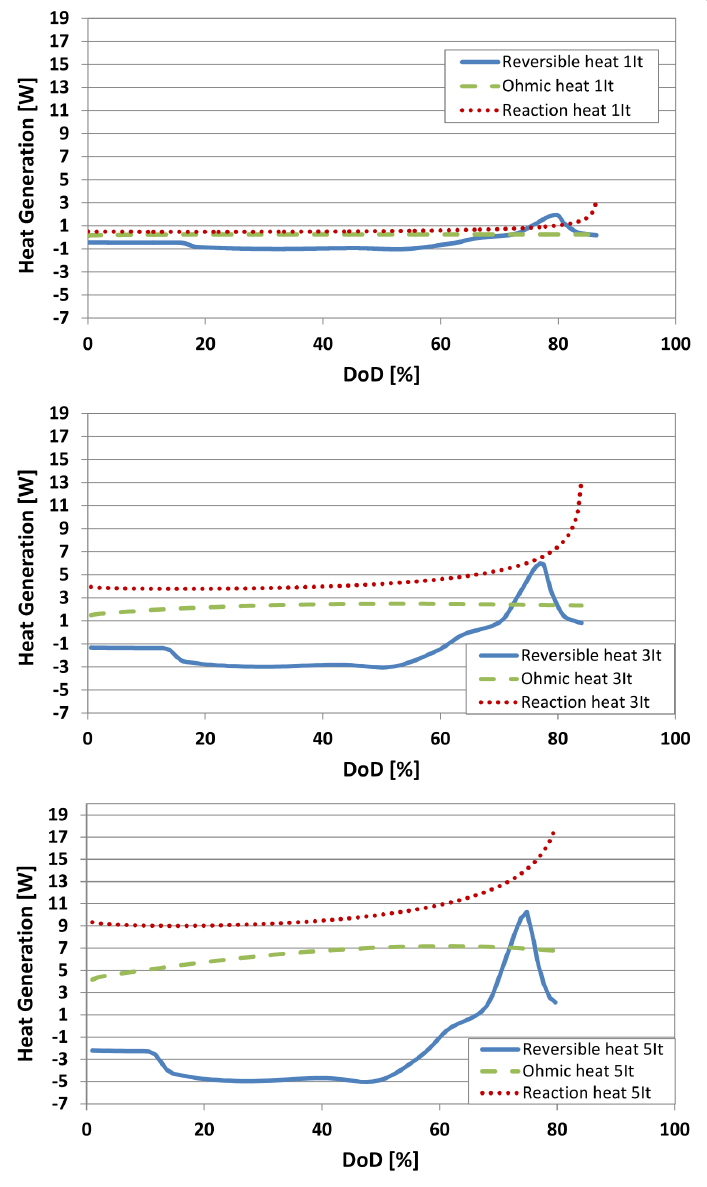
Figure 18. Ohmic, reversible and reaction heat generations during the discharges of the